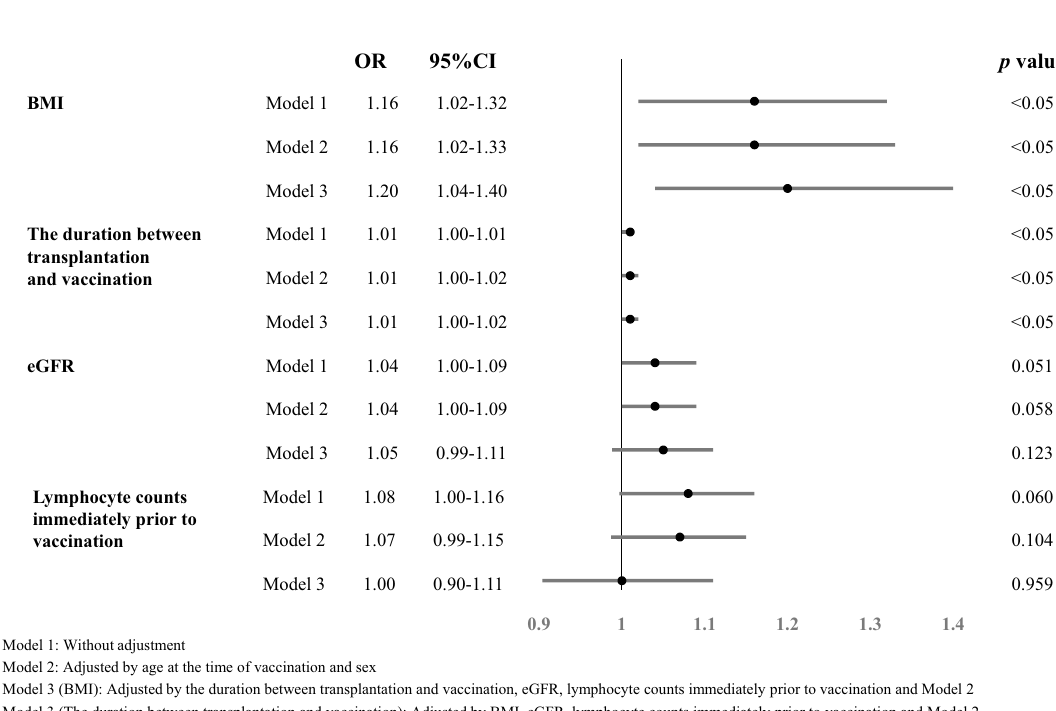
Figure 3. Quantification of antibody titers in ABO-compatible and ABO-incompatible kidney transplant recipients. The dots indicate the values of SARS-CoV2 spike-IgG Antibodies. The dotted line indicates the cutoff value.